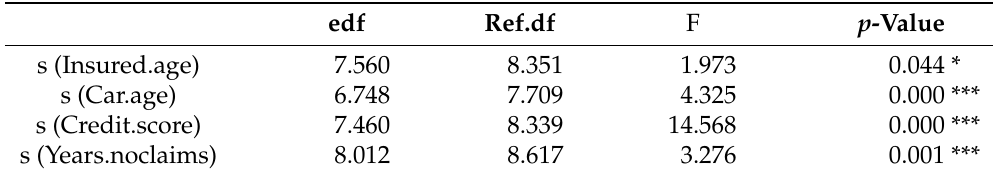
Table 5. The statistical significance of smooth terms for Insured Age, Car Age, Credit Scores, and Years of no Claims,